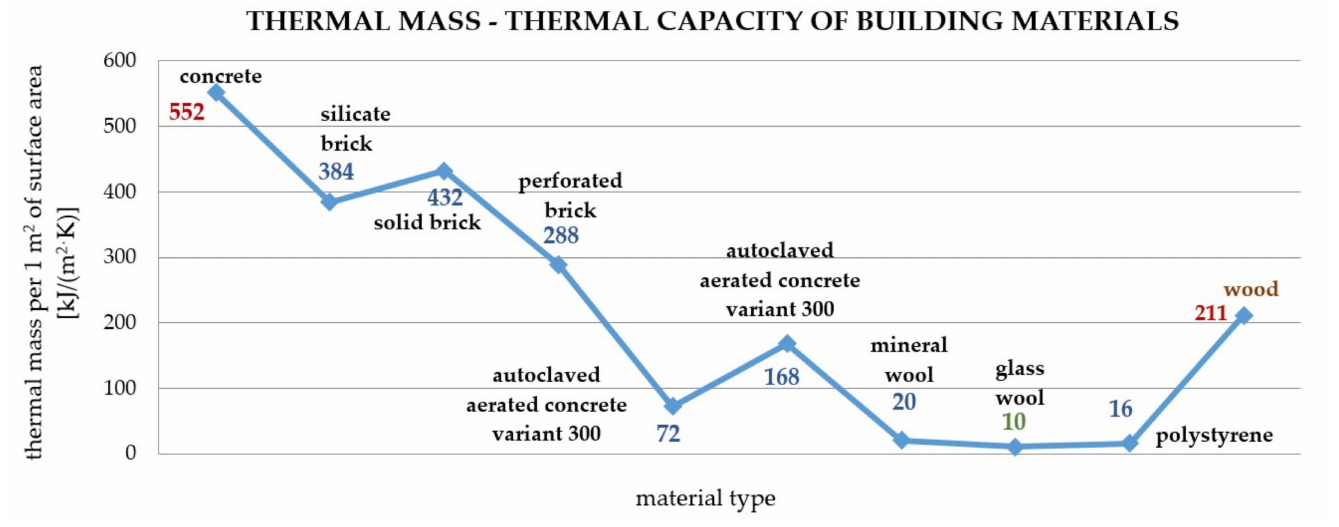
Figure 1. Thermal mass—thermal capacity of building